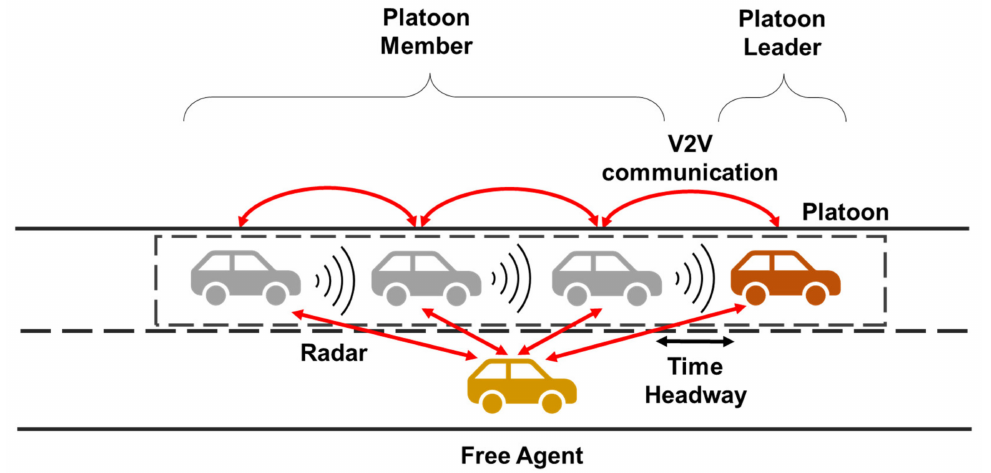
Figure 1. Decentralized platooning system of connected and automated